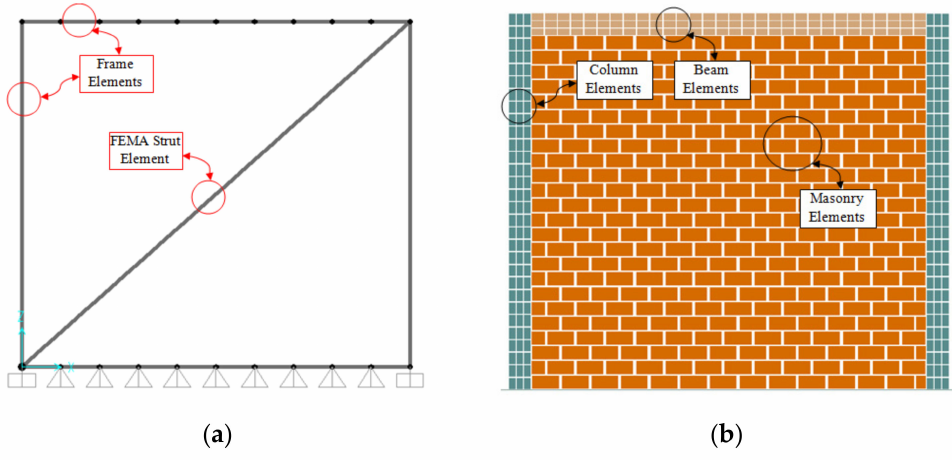
Figure 11. FEMA: (a) strut Finite Element Model ( b ); Continuum Applied Element model of infilled wall structure.